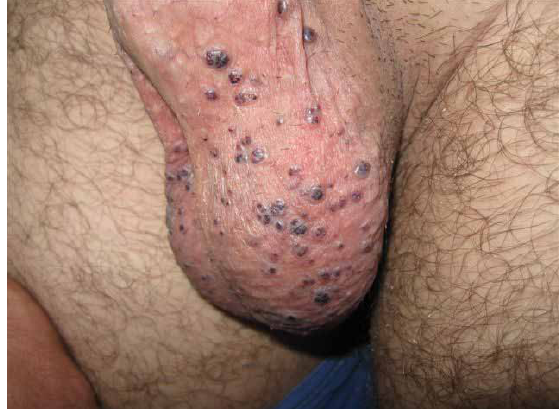
Figure 1. Angiokeratoma of the scrotum – multiple lesions